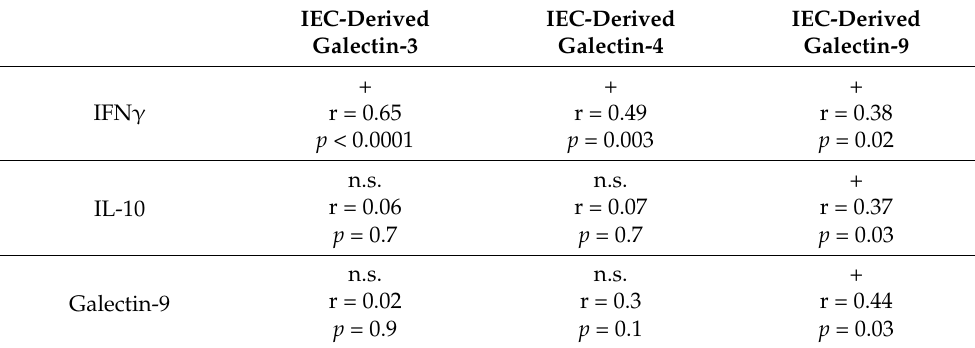
Table 1. Correlations of cytokines and galectin-9 in the IEC/PBMC co-culture and IEC-derived galectins. Cytokine and galectin-9 secretions measured in the IEC/PBMC co-culture were correlated to IEC-derived galectin concentrations (48 h) using Pearson